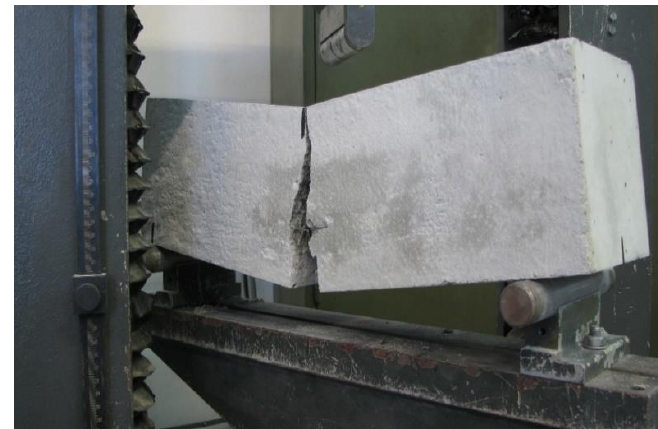
Figure 3. Concrete specimen after the CMOD test.